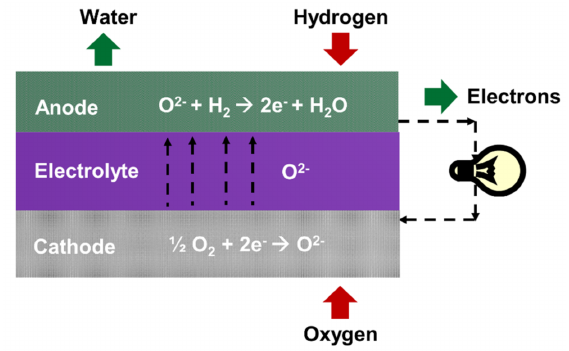
Figure 1. Schematic of solid oxide fuel